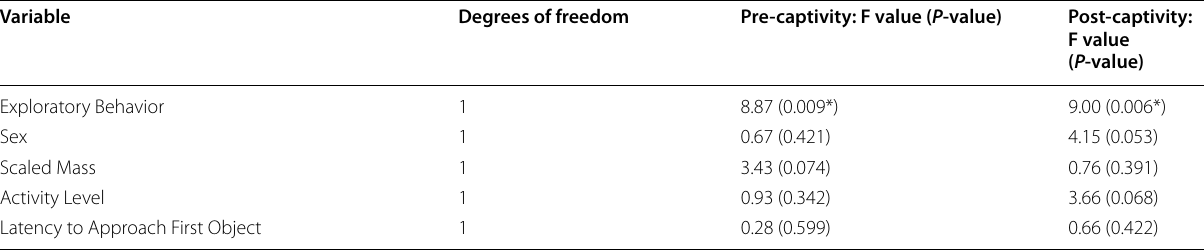
* indicates significance at 0.05